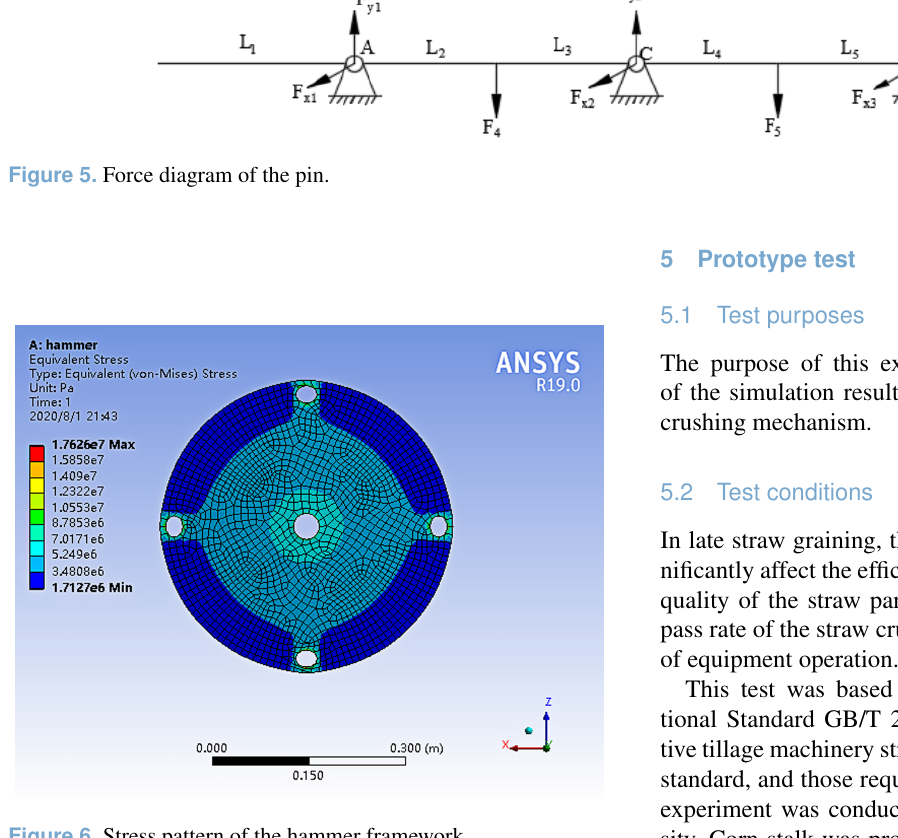
Figure 6. Stress pattern of the hammer framework.